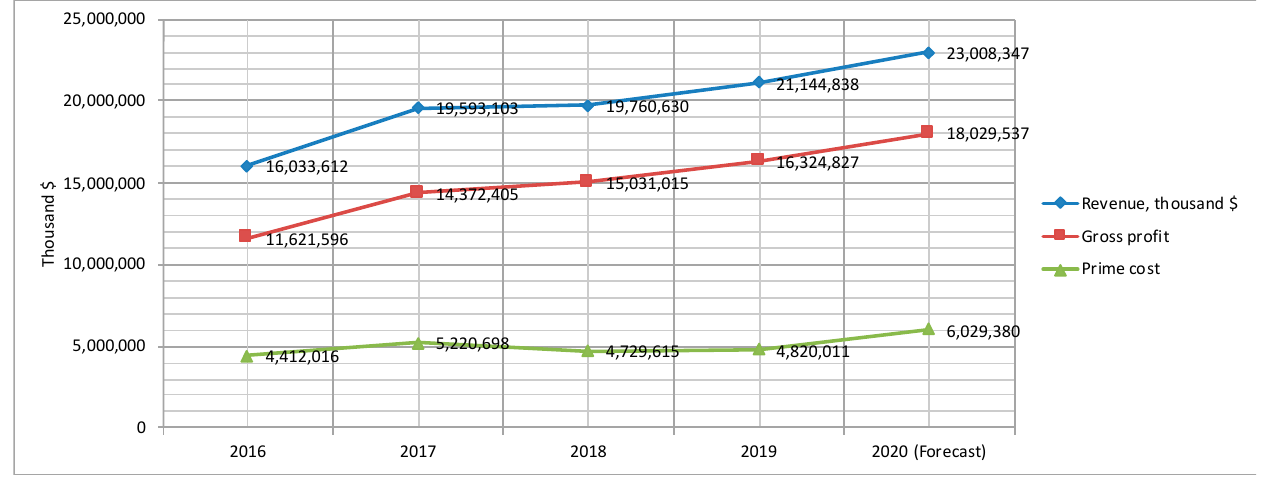
properly and the service level is ideal, i.e., ELT = 1, and the probability of a risk event is The forecast results show that the company can get total revenue of $ 23,008.3 million and a gross profit of USD 6029.4 million (Figure 3).